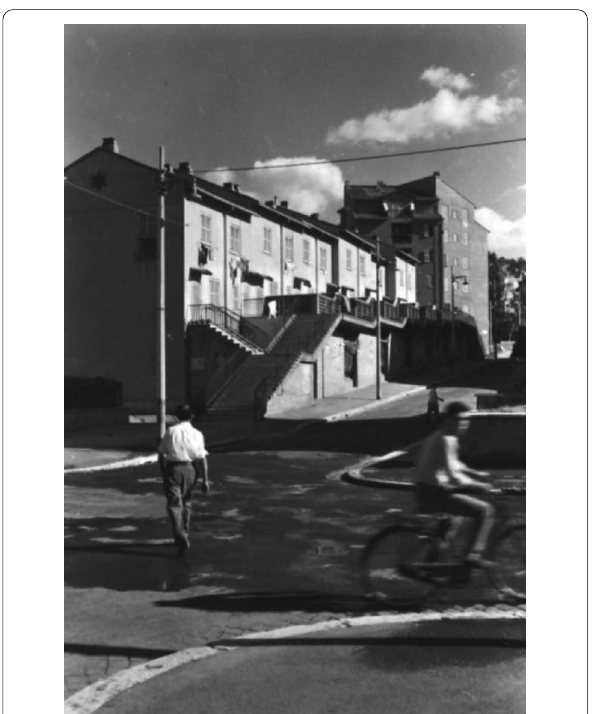
Fig. 13 Mario Ridolfi and others, Quartiere Ina‑Casa Tiburtino a Roma. Lotto B, case con ballatoio, riproduzione fotografi ca.